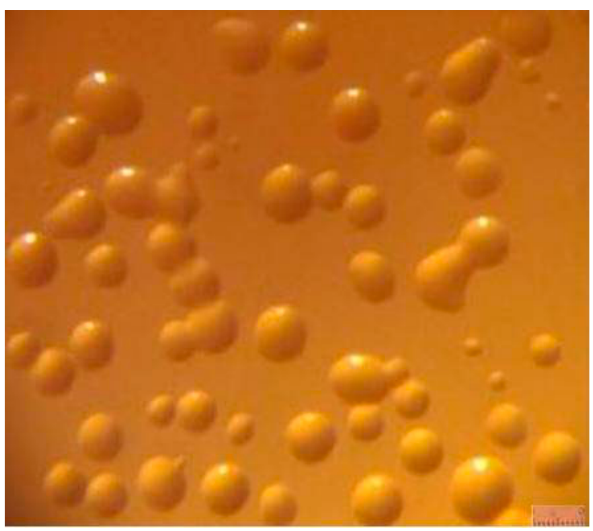
Figure 2. Colony morphology of a Xylella fastidiosa strain isolated from pistachio on PD2 agar medium, after incubation at 28°C after 12 days (Scale bar = 1